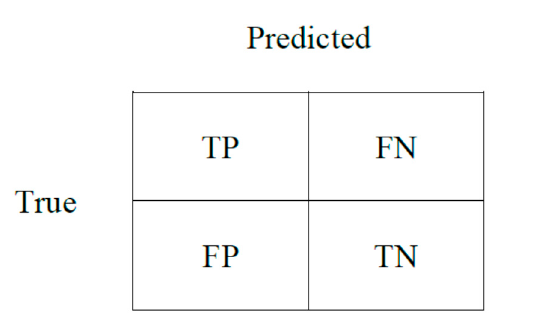
Figure 6. Confusion Matrix.